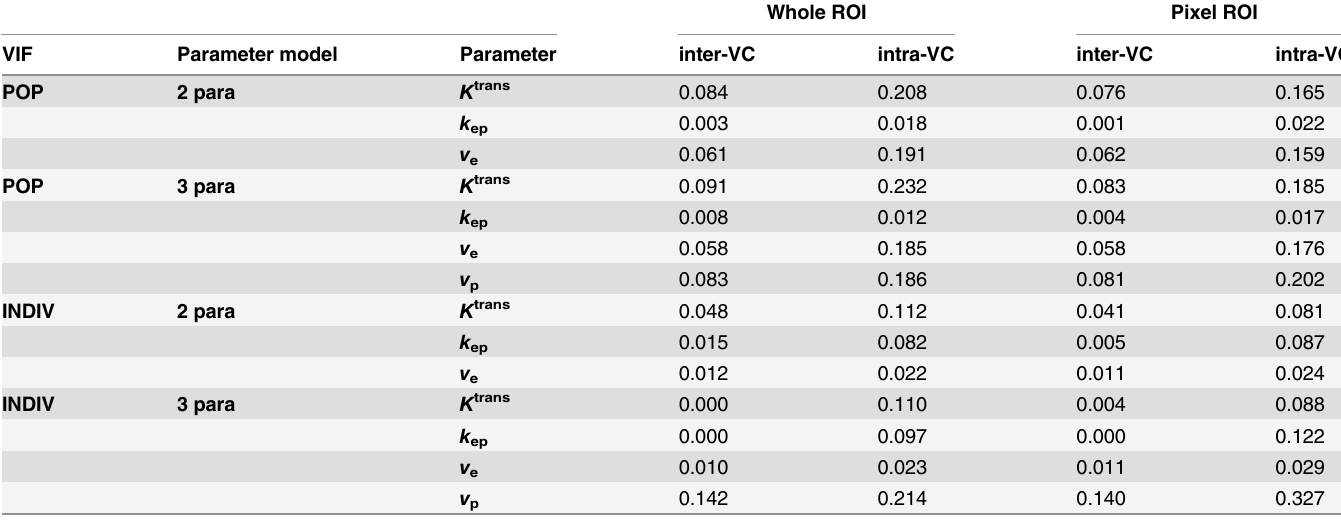
Table 3. Summary of variance components analysis, by analytical method (n = 12). Model dependent ( K trans , k ep , v e and v p